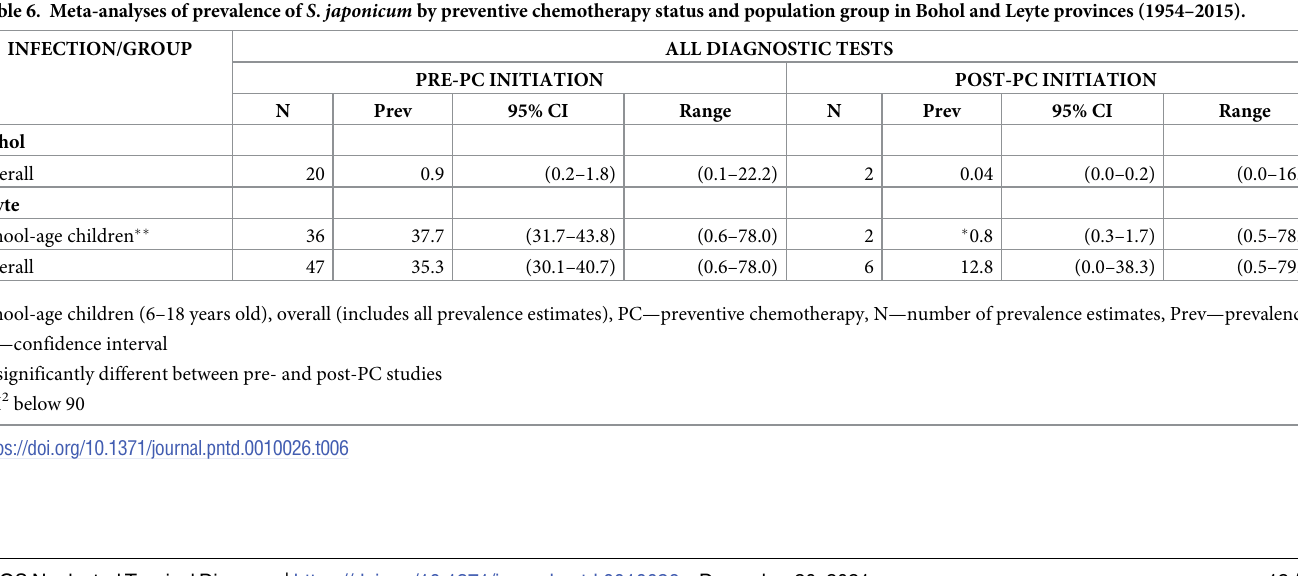
(Table 6). Pooled prevalence of schistosomiasis in Leyte after preventive chemotherapy initia- tion was 12.8%, while the prevalence prior to preventive chemotherapy initiation was 35.3% (Table 6). When meta-analysis was restricted to only include prevalence estimates obtained within five years before or after preventive chemotherapy initiation, no reduction in prevalence of schistosomiasis was observed. Prevalence prior to preventive chemotherapy initiation from 7 prevalence estimates was at 9.4% (95% CI 0.0–23.8%) with I 2 = 99.3, while prevalence after pre- ventive chemotherapy initiation from 21 prevalence estimates was 22.5% (95% CI 5.8%-41.8%) with I 2 = 99.7.